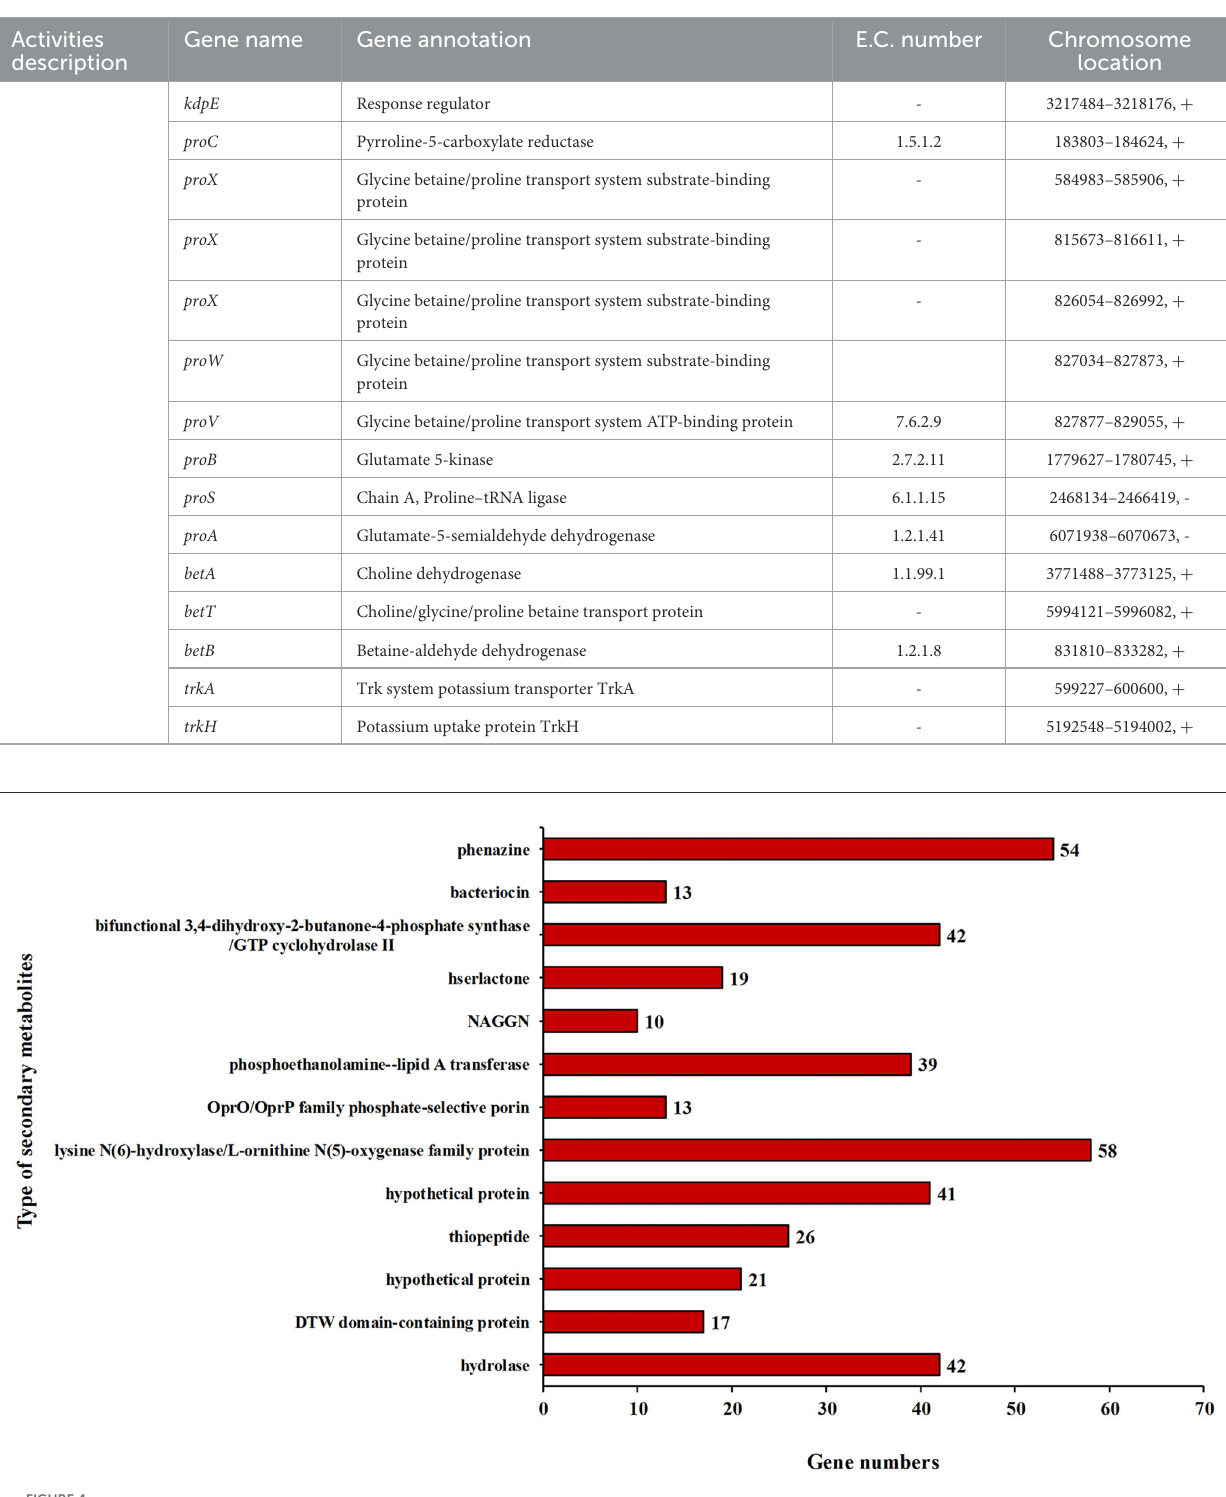
various genes such as tonB, fabY , fur , fepA , fecAEI , and fhuE . Similar to the present study, the siderophore synthesis pathway-related gene fepEGDC also exists in the genome of strain B. subtilis EA- CB0575 (Franco-Sierra et al.,